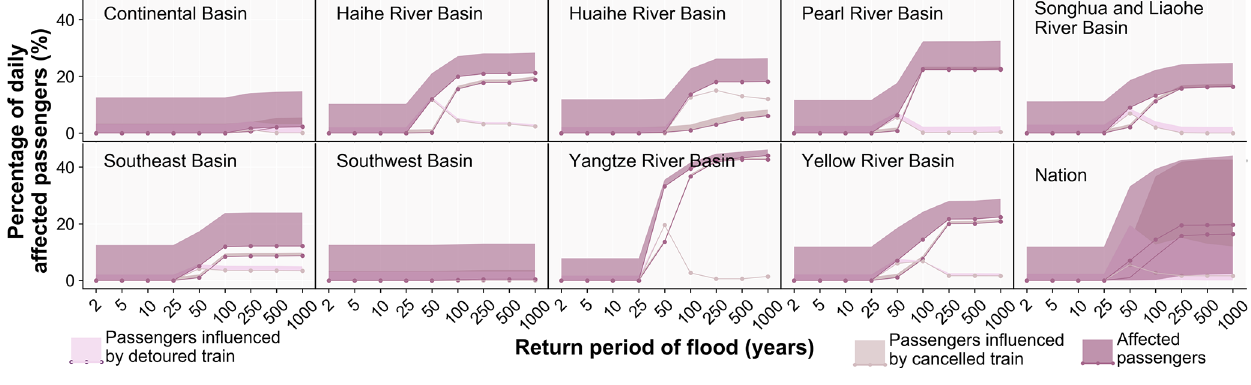
Figure A6. System vulnerability curves of passenger’s metrics.